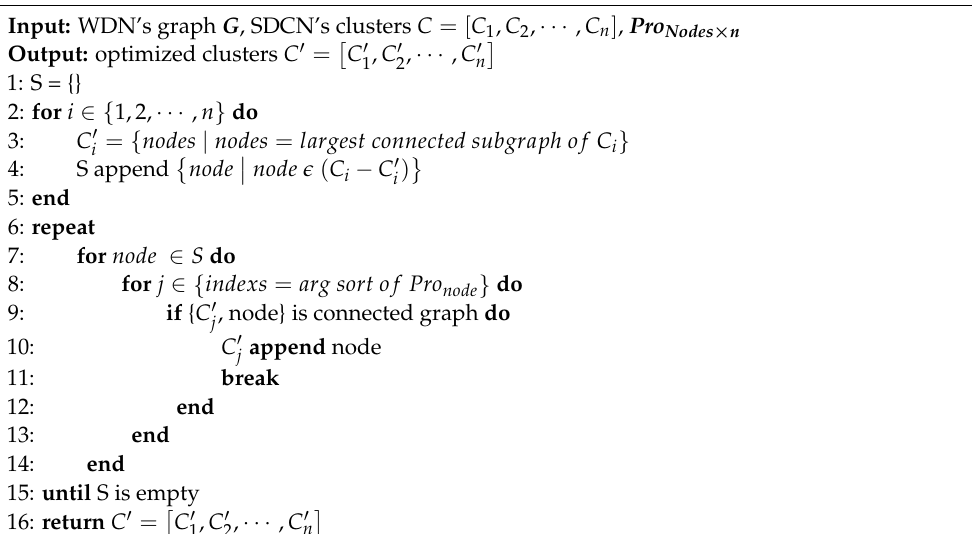
Algorithm 1 Monitoring partition establishment